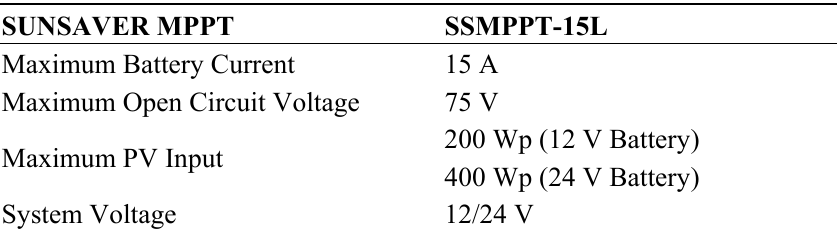
Table 3. Specifications of Sunsaver MPPT.